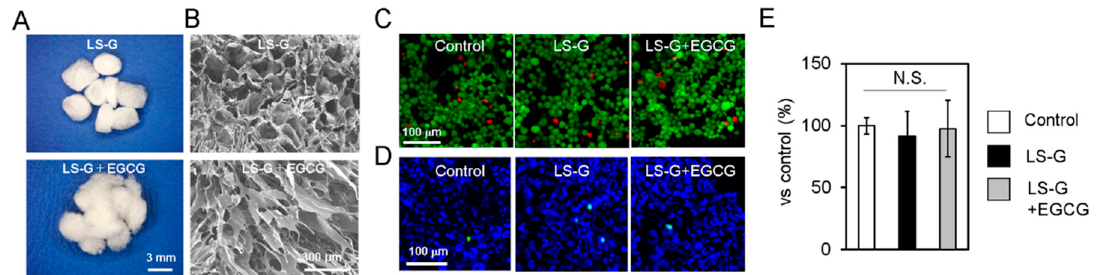
Figure 2. Characteristics of sponges. Macroscopic ( A ) and field-emission scanning electron microscopic ( B ) images of sponges. LS-G, LPS sustained-release gelatin sponges; LS-G+EGCG, LS-G chemically modified with EGCG. ( C – E ) Evaluation of cytotoxicity of LS-G and LS-G+EGCG in vitro. The osteoblastic cell line UMR106 was treated with or without the sponges for three days. Control, without the sponges. ( C ) Live and dead cell staining. Green, live cells; red, dead cells. ( D ) Apoptosis analysis. Green, apoptotic cells; blue, DAPI (4 ′ ,6-diamidino-2-phenylindole) staining representing nuclei. ( E ) Cell counting kit (CCK-8) colorimetric assay. Data are expressed as mean ± standard deviation (SD), n = 4. N.S., not significant.